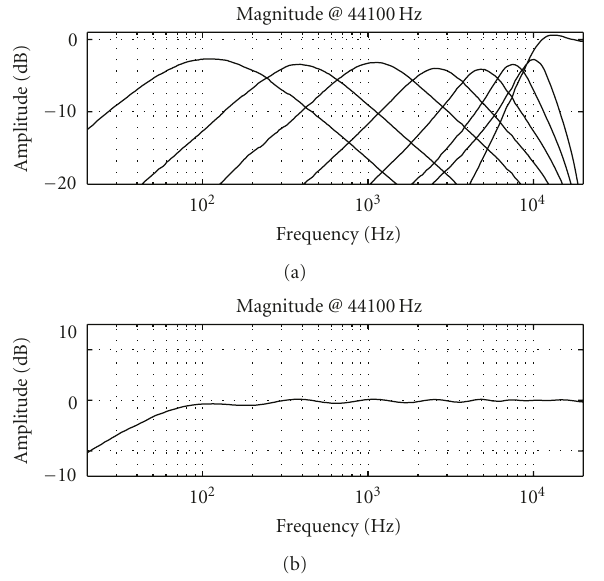
Figure 2: Quasiflat frequency response bandpass filter bank (Type A filter bank for K = 8). (a) Filter bank consisting of a set of eight second order band-pass IIR Biquadratic filters with center frequencies as follow: 100 Hz, 400 Hz, 1kHz, 2.5 kHz, 5 kHz, 7.5kHz, 10kHz, and 15000 kHz. (b) Combined response of the filter bank.